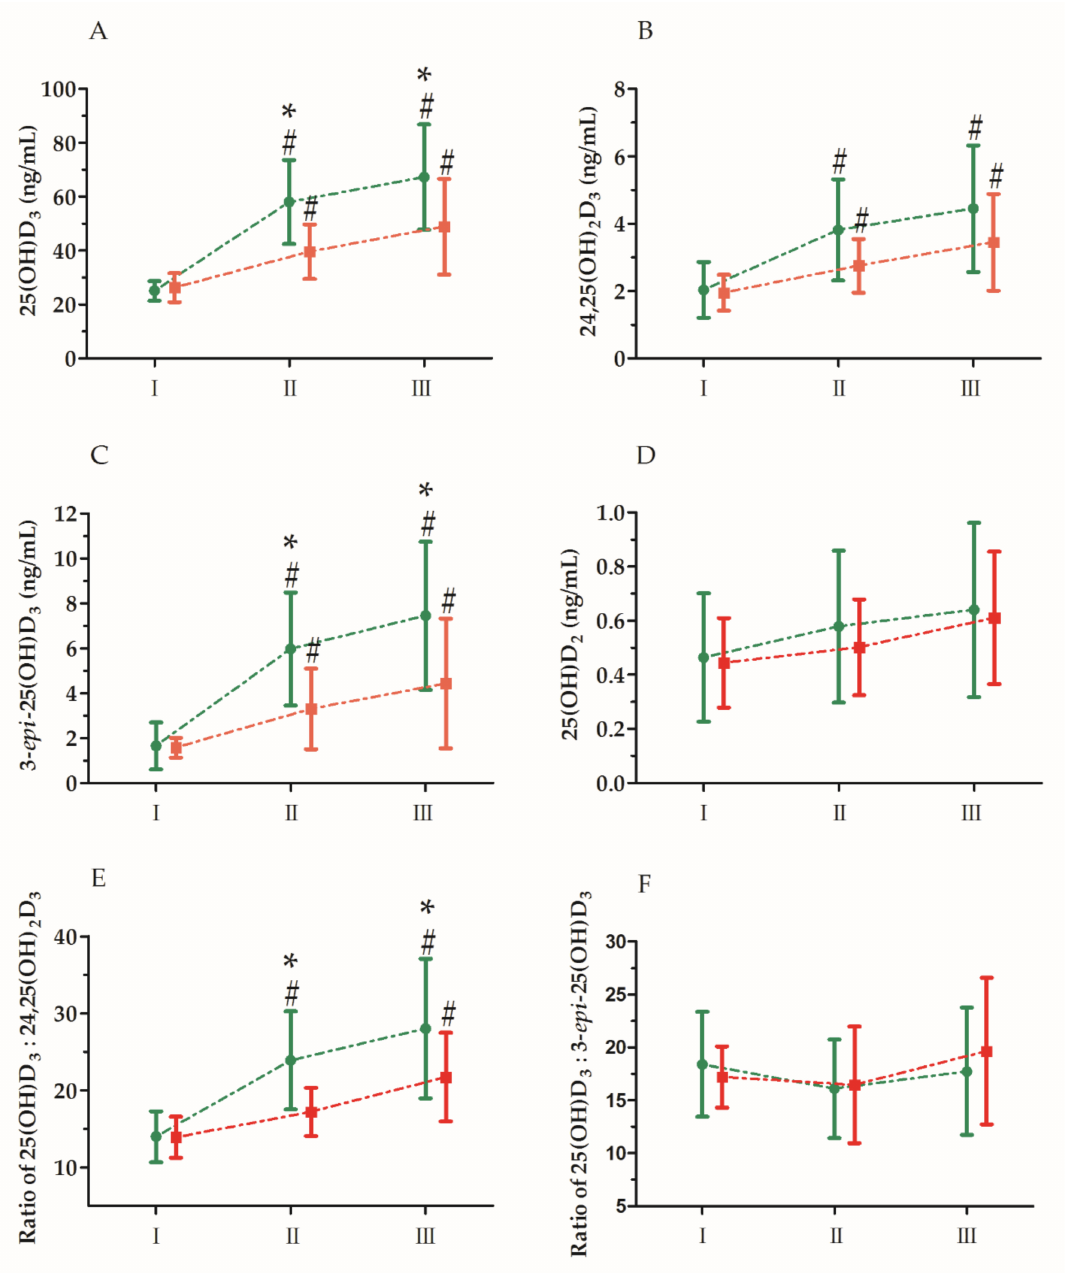
Figure 3. An e ff ect of ultra-marathon on the serum levels of vitamin D metabolites. Data for runners supplemented with vitamin D 3 (green symbols and lines) and runners without supplementation (red symbols and lines) are shown. ( A ) 25(OH)D 3 levels; ( B ) 24,25(OH) 2 D 3 levels; ( C ) 3- epi -25(OH)D 3 levels; ( D ) 25(OH)D 2 levels; ( E ) 25(OH)D 3 : 24,25(OH) 2 D 3 ratio; ( F ) 25(OH)D 3 : 3- epi -25(OH)D 3 ratio. Time points: I, 24 h before the ultra-marathon; II, immediately after the ultra-marathon; III, 24 h after the ultra-marathon. The values are presented as mean ± SD. * significant di ff erence vs. group without supplementation at p < 0.05; # significant di ff erence vs. I time point at p <